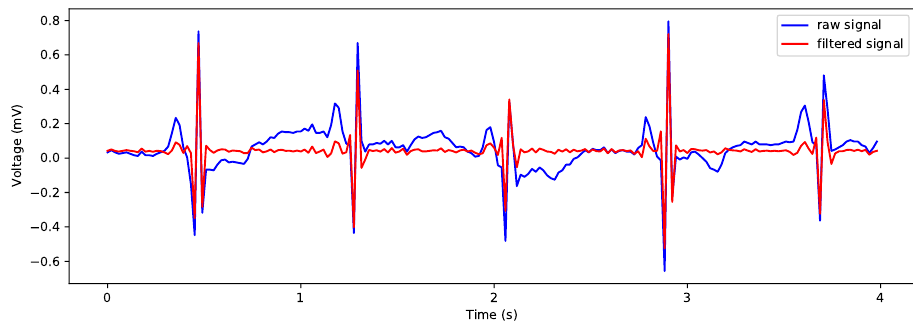
Figure 3. Raw and filtered ECG signal with visible R peaks in a 4 s